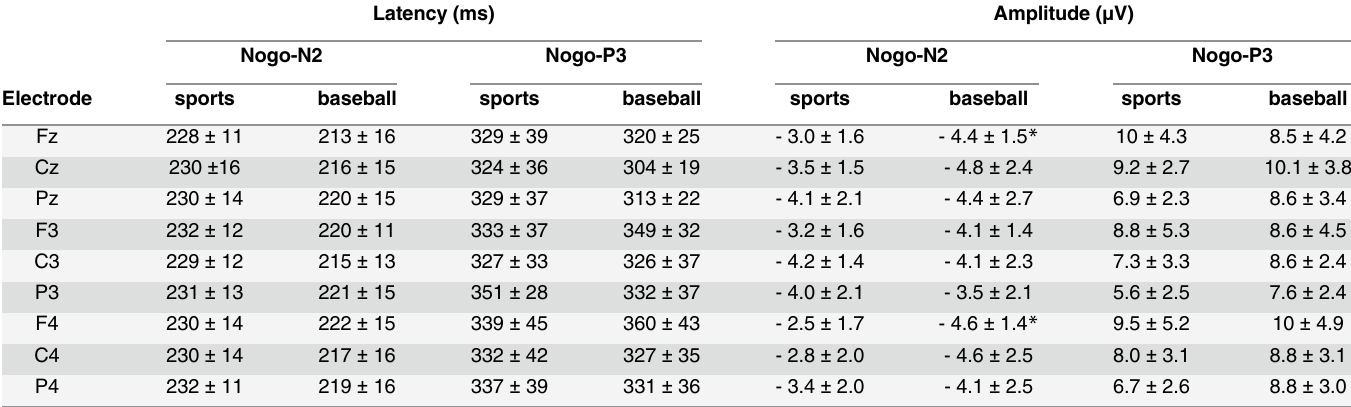
Table 1. The peak latency and amplitude ± S.D of Nogo-N2 and